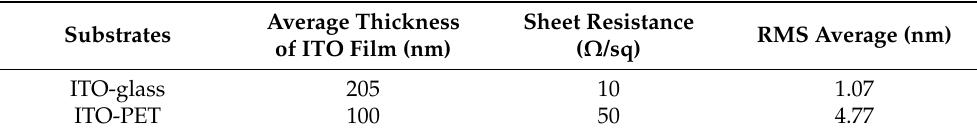
Table 1. Summary of different parameters of the ITO covered glass or PET used in this work. RMS stands for Roughness Mean Square. Average Thickness Sheet Resistance Substrates RMS Average (nm) of ITO Film (nm) ( Ω /sq) ITO-glass 205 ITO-PET